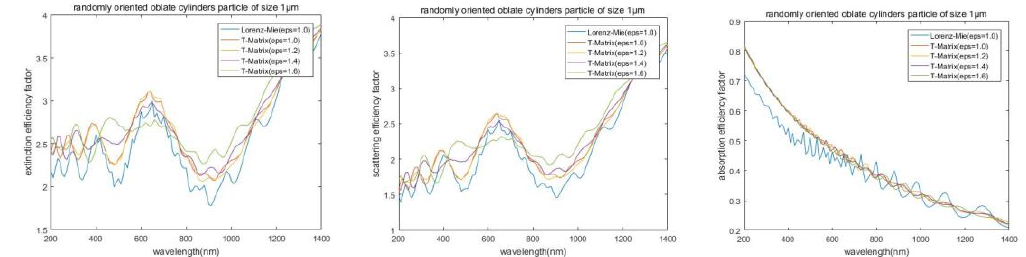
Figure 7. Comparison of extinction efficiency factor (left), scattering efficiency factor (middle) and absorption efficiency factor (right) of randomly oriented cylinders by T-matrix method and Lorenz-Mie theory with different wavelengths and shapes (refractive index is 1.55+0.01i, particle size is 1